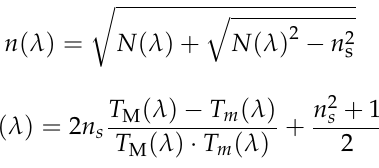
2 O 3 sample under